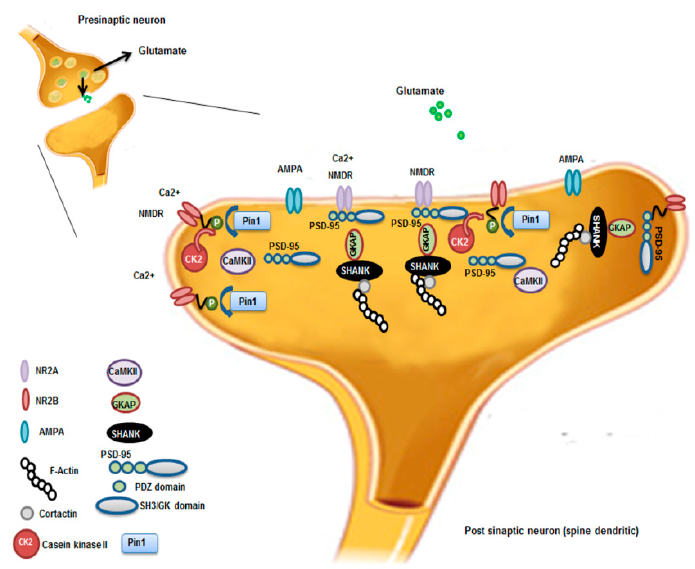
Figure 2. Pin1 regulation of NMDAR complex and synaptic plasticity. Synaptic activation of NMDAR stimulates Ca2 + /Calmodulin-dependent protein Kinase II (CaMKII) and casein kinase II (CK2) activity. CK2 phosphorylates the PDZ (postsynaptic density-95(PSD-95)/Discs large/zona occludens-1) ligand of NR2B. Pin1 binds and stabilizes probably the conformational change of NR2B phosphorylated disrupting the interaction between NMDAR on the cell surface and the PDZ domains of PSD-95. This leads to destabilization and internalization of surface NMDAR that influences, in turn, synaptic transmission and spine morphology. NR2A; NR2B; AMPA; F-Actin; Contarctin; CaMKII, Ca2 + -Calmodulin dependent protein Kinase II; CK2, casein Kinase 2; PSD-95 presents three PDZ domains, SH3 (Sarc homology 3 domain) and GK (guanylate kinase-like domain) domains; Pin1; GKAP, Guanylate kinase associate protein; Shank, shank protein.